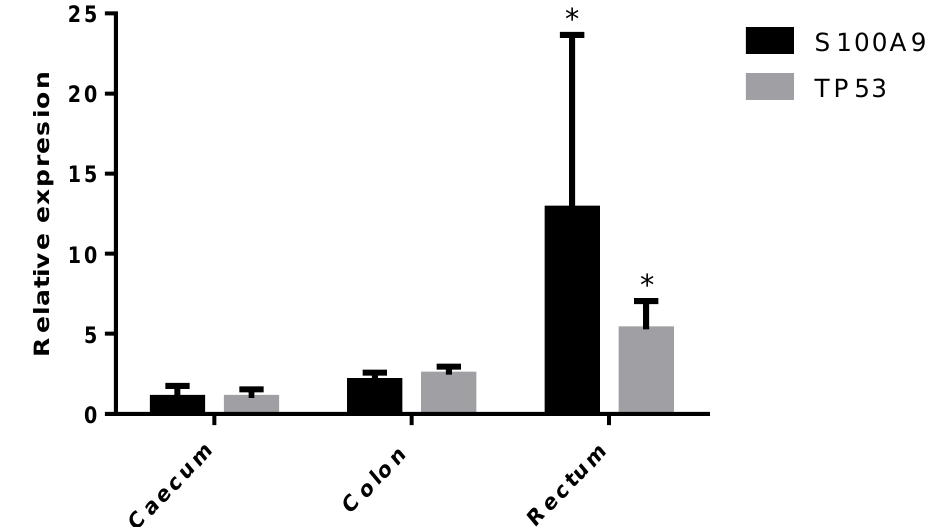
Figure 3. S100A9 and TP53 expression by tissue location. Data are expressed as 2 −ddCt . * p < 0.05 vs. caecum.